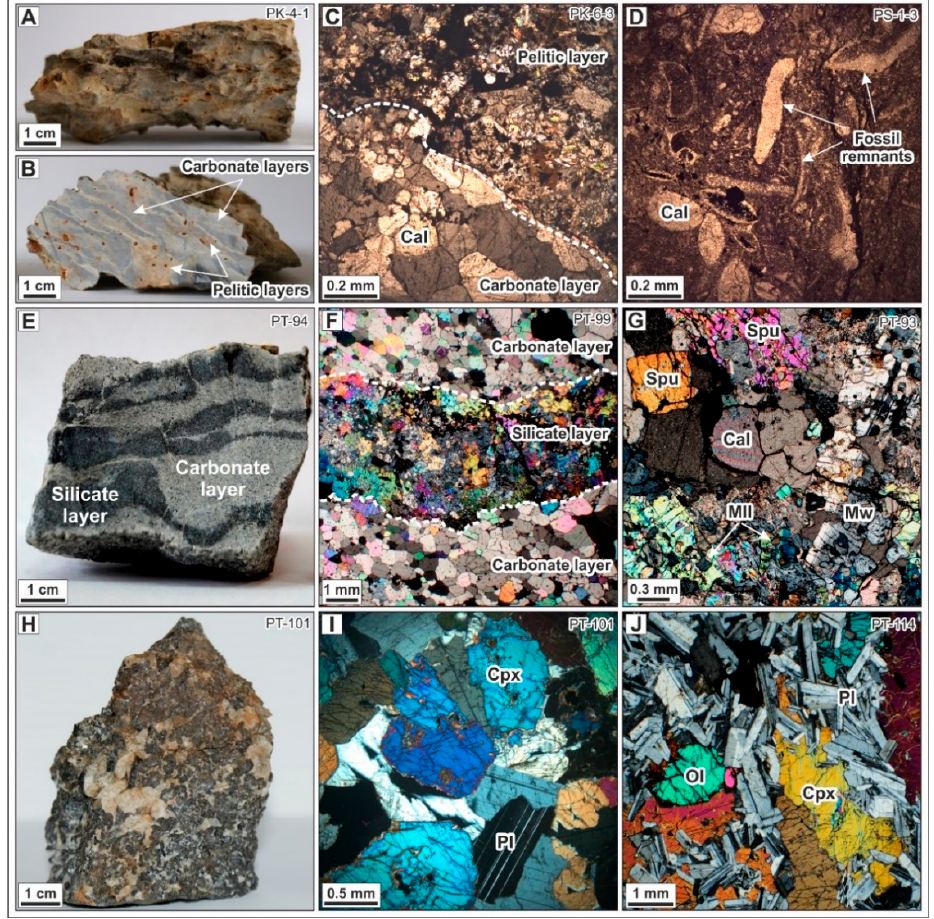
Figure 3. Appearance of recrystallized marly limestones ( A–D ), marbles ( E–G ) and gabbro ( H–J ) from the Kochumdek contact aureole. Recrystallized marly limestones: ( A) Weathered limestone surface. ( B,C ) Distribution of carbonate and pelitic layers in limestone. ( D ) Marly limestone with partially recrystallized fossil remnants. Spurrite marbles: ( E ) Typical sample of spurrite marble. ( F ) Silicate and carbonate layers. ( G) Calcite + Spurrite + Merwinite + Melilite. Gabbro: ( H ) Gabbro from the Kochumdek intrusion top. ( I , J ) Coarse-grained clinopyroxene, with interstitial plagioclase and olivine. ( C,D,F,G,I,J ) Optical images in cross-polarized transmitted light. Collection: A-D = 2017, E-J = 1981. Cal = calcite, Cpx = clinopyroxene, Mll = melilite, Mtc = monticellite, Mw = merwinite, Ol = olivine, Pl = plagioclase, Spu = spurrite.